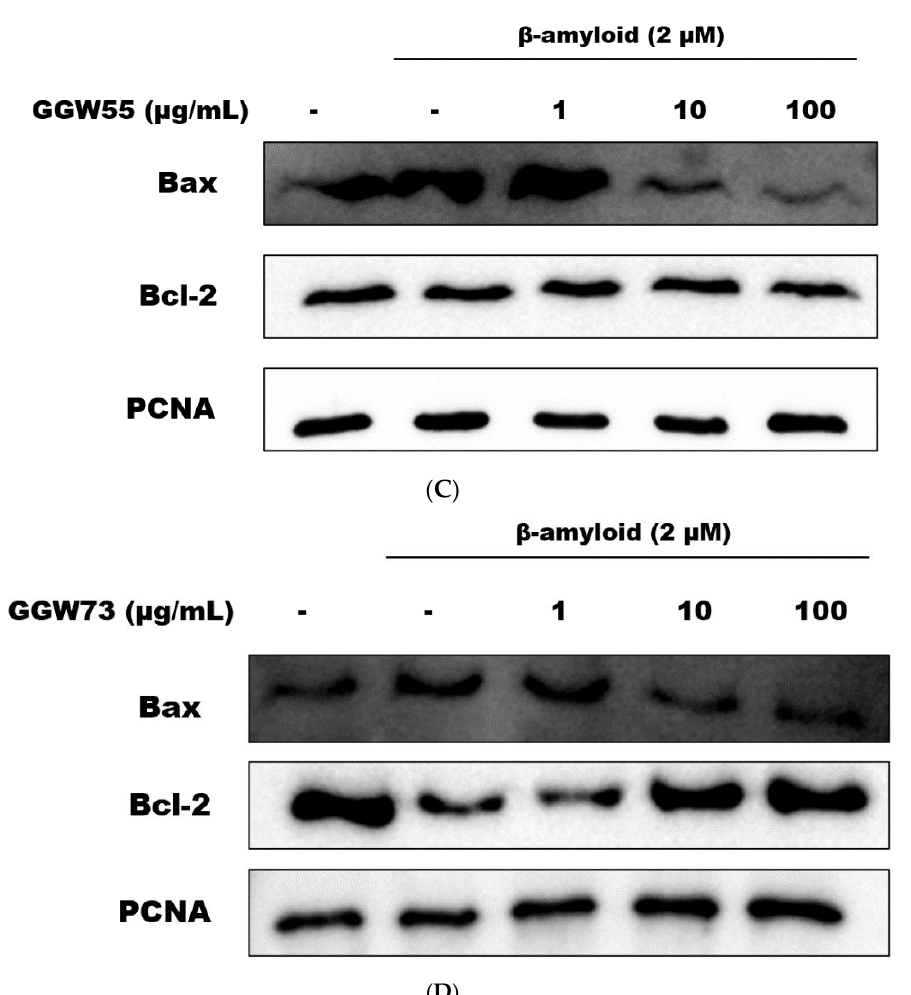
Figure 5. The attenuation effect of GGW on A β -stimulated apoptotic factors on SK-N-SH cells. The attenuation effect of GGW55 and GGW73 on A β -stimulated apoptotic factors on SK-N-SH cell. The cells were treated with GGW55 and GGW73, after 4 h A β (2 µ M) were treated for 24 h. ( A ) Bcl-2 mRNA expression on SK-N-SH cell with GGW55 and GGW73. ( B ) Beclin-1 mRNA expression on SK-N-SH cell with GGW55 and GGW73. ( C ) Bax and Bcl-2 expression on SK-N-SH cell with GGW55. ( D ) Bax and Bcl-2 expression on SK-N-SH cell with GGW73. The protein expressions were measured using Western blot analysis. All values are expressed as the mean ± S.E.M from three independent experiments.; # p < 0.05 compared with none-treatment group; * p < 0.05 compared with none-treatment group.